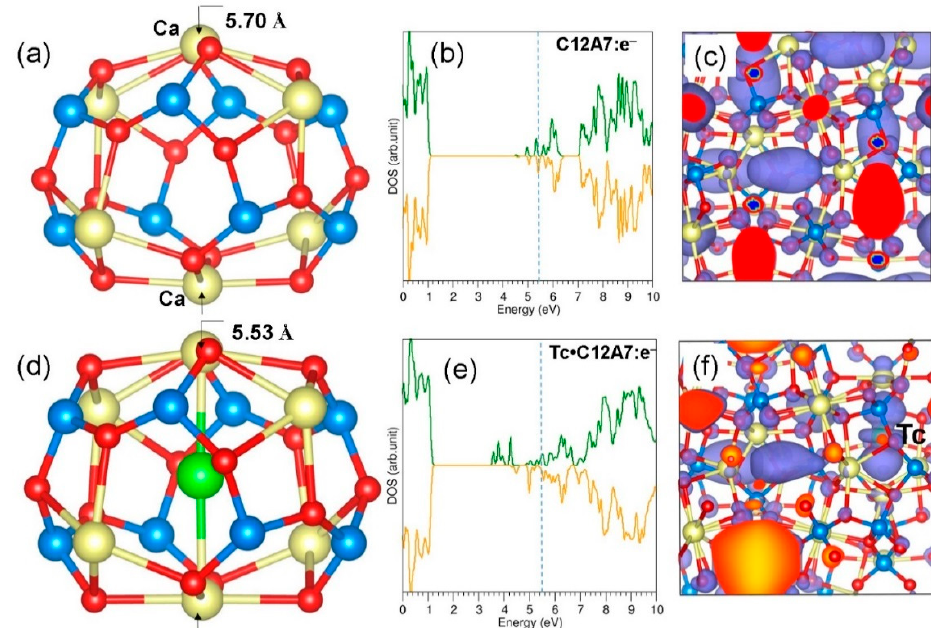
Figure 4. ( a ) Relaxed empty cage showing the Ca–Ca pole distance in C12A7:e − ; ( b ) DOS plot calculated for C12A7:e − ; ( c ) charge density plot showing four electrons delocalised in C12A7:e − ; ( d ) relaxed cage containing Tc; ( e ) DOS plot calculated for Tc: C12A7:e − ; and ( f ) charge density plot showing the localisation of some electrons on the Tc atom.